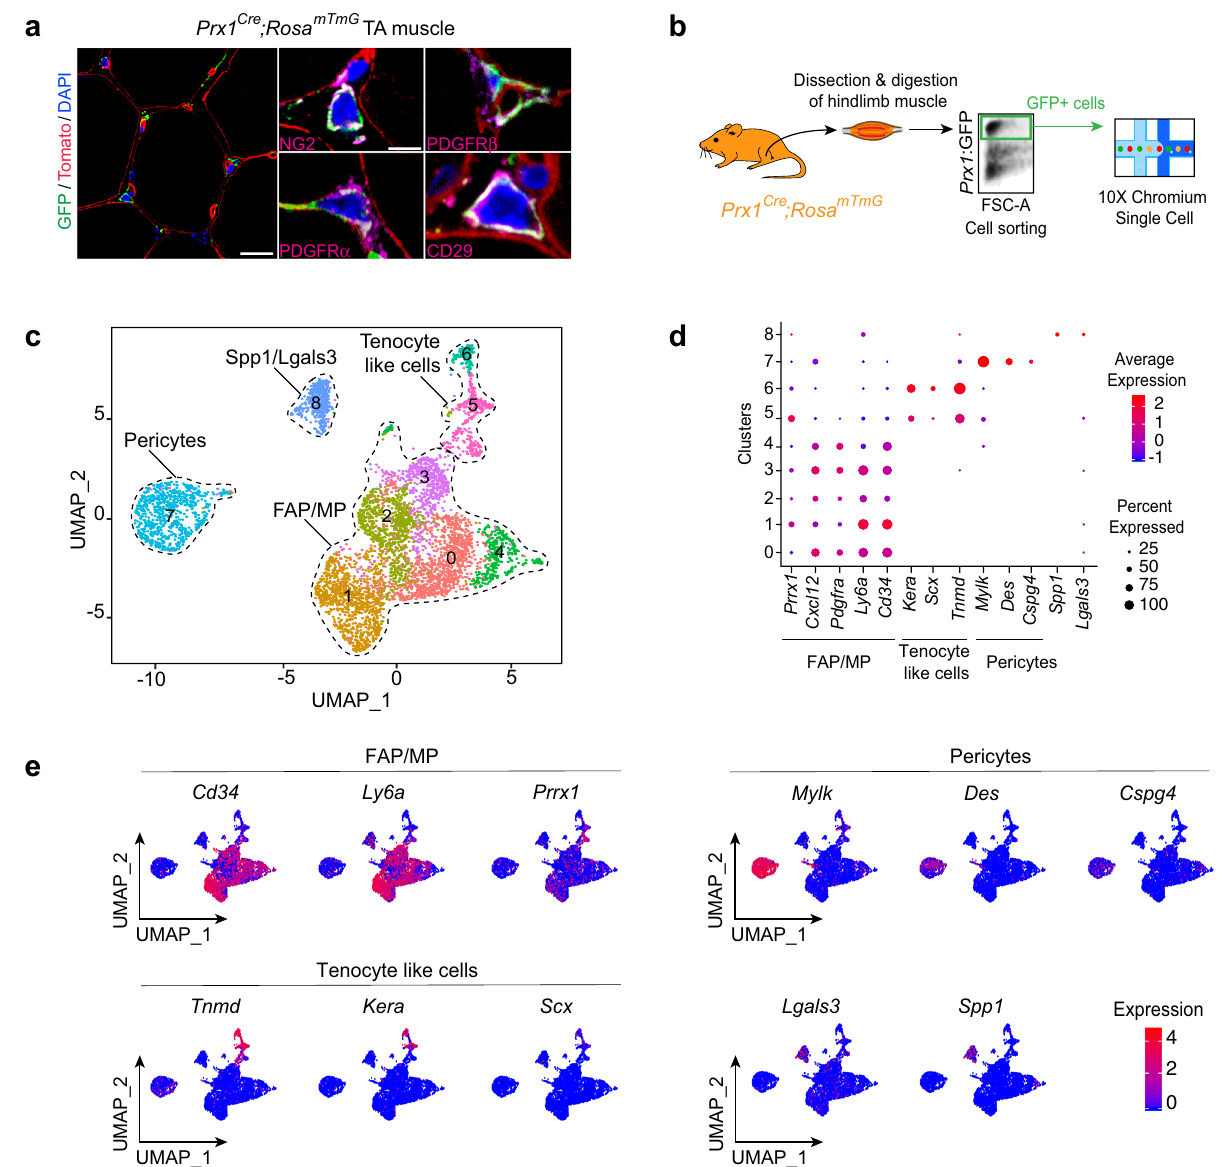
Fig. 2 Single-cell analyses of skeletal muscle mesenchymal progenitors in intact muscle. a Transverse sections of TA muscle from Prx1 Cre ;Rosa mTmG mice immunostained with NG2, PDGFR β , PDGFR α , or CD29 antibodies (magenta). DAPI-labeled nuclei in blue, GFP-labeled Prx1-derived cells in green and Tomato labeled non Prx1-derived cells in red. Representative images of three distinct samples. b Experimental design of scRNAseq experiment. Prx1- derived skeletal muscle cells were isolated from hindlimb skeletal muscles and sorted based on GFP-expression prior to scRNAseq. c UMAP projection of color-coded clustering of Prx1-derived cells reveals nine clusters de fi ning four distinct populations (limited by a black dotted line). d Dotplot of indicated gene expression identifying FAP/MP, tenocyte-like cell, pericyte and Spp1/Lgals3 populations. e FeaturePlot of sub-population marker expression ( Cd34 , Ly6a , and Prrx1 for FAP/MP, Tnmd, Kera , and Scx for tenocyte like cells, Mylk, Des , and Cspg4 for pericytes and Lgals3 and Spp1 for Spp1/Lgals3 cells).